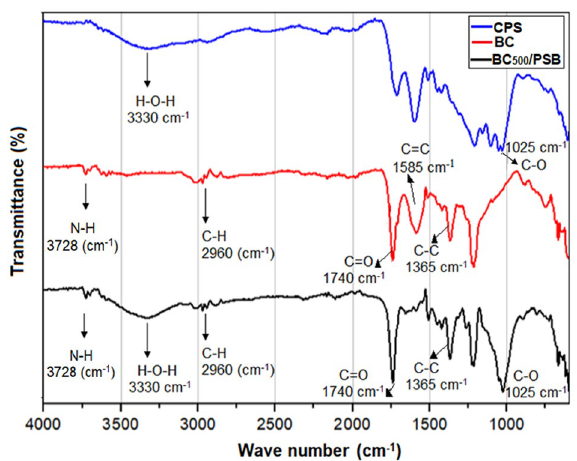
Figure 1. Fourier transformed infrared spectroscopy (FITR) for Caribe Pine sawdust (CPS), (Blue line), biochar (BC 500 ), (Redline) and biochar co-inoculated with PSB (BC 500 /PSB),